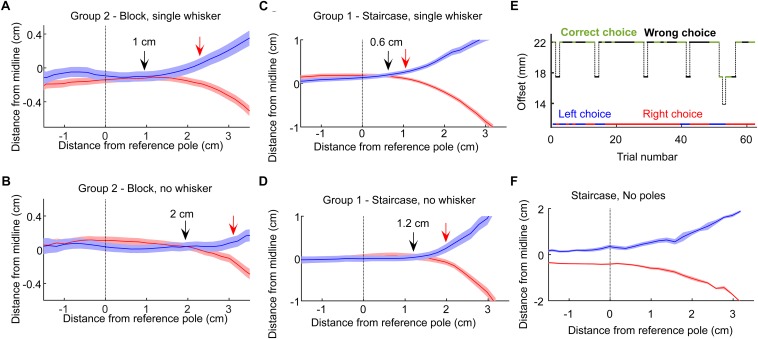
Decision points. (A) The mean and standard error of the head trajectories in left choice (blue) and right choice (red) trials for the rats in Group 2 (Narrow geometry, Block training). Data from the 3 sessions before trimming the single whisker. Solid arrow marks the last point where the left and right trajectories diverged. Red arrow marks the first point in which the difference between the two trajectories was larger than twice the sum of the standard errors from both trajectories. (B) Same as (A), but for the 3 sessions after trimming the single whisker. (C,D) same as (A,B), but at the Narrow/Staircase configuration. (E) A single session example from a control session. In control sessions the poles were removed from the setup. The pole base was still moving with the same logic (controlling for sound-based discrimination). Animal performance dropped to chance, with typically long epochs of repeated choice (here, a right-choice sequence is seen), showing that rats rely on tactile rather than auditory cue in the task. (F) Left/right head trajectories in the no-pole condition.